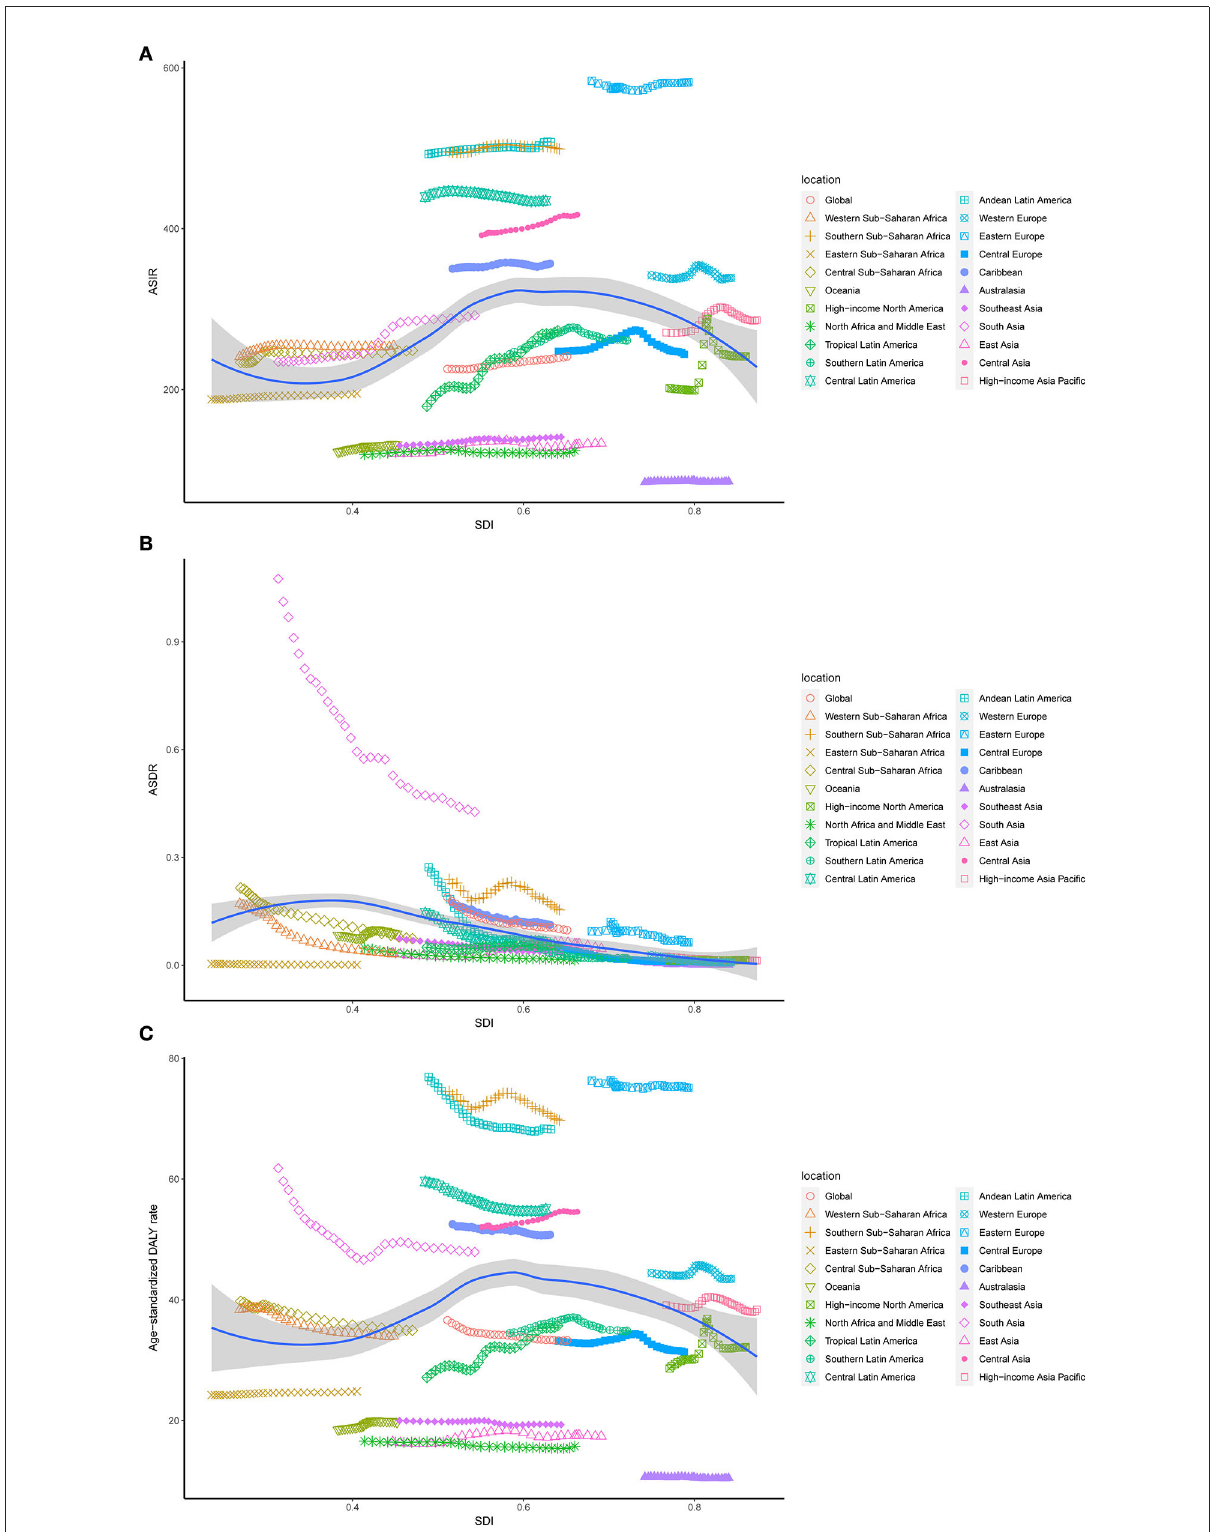
FIGURE3 The ASR rates of UFs per 100,000 population among regions based on SDI in 2019. (A) Age-standardized incidence; (B) age-standardized death; (C) age-standardized